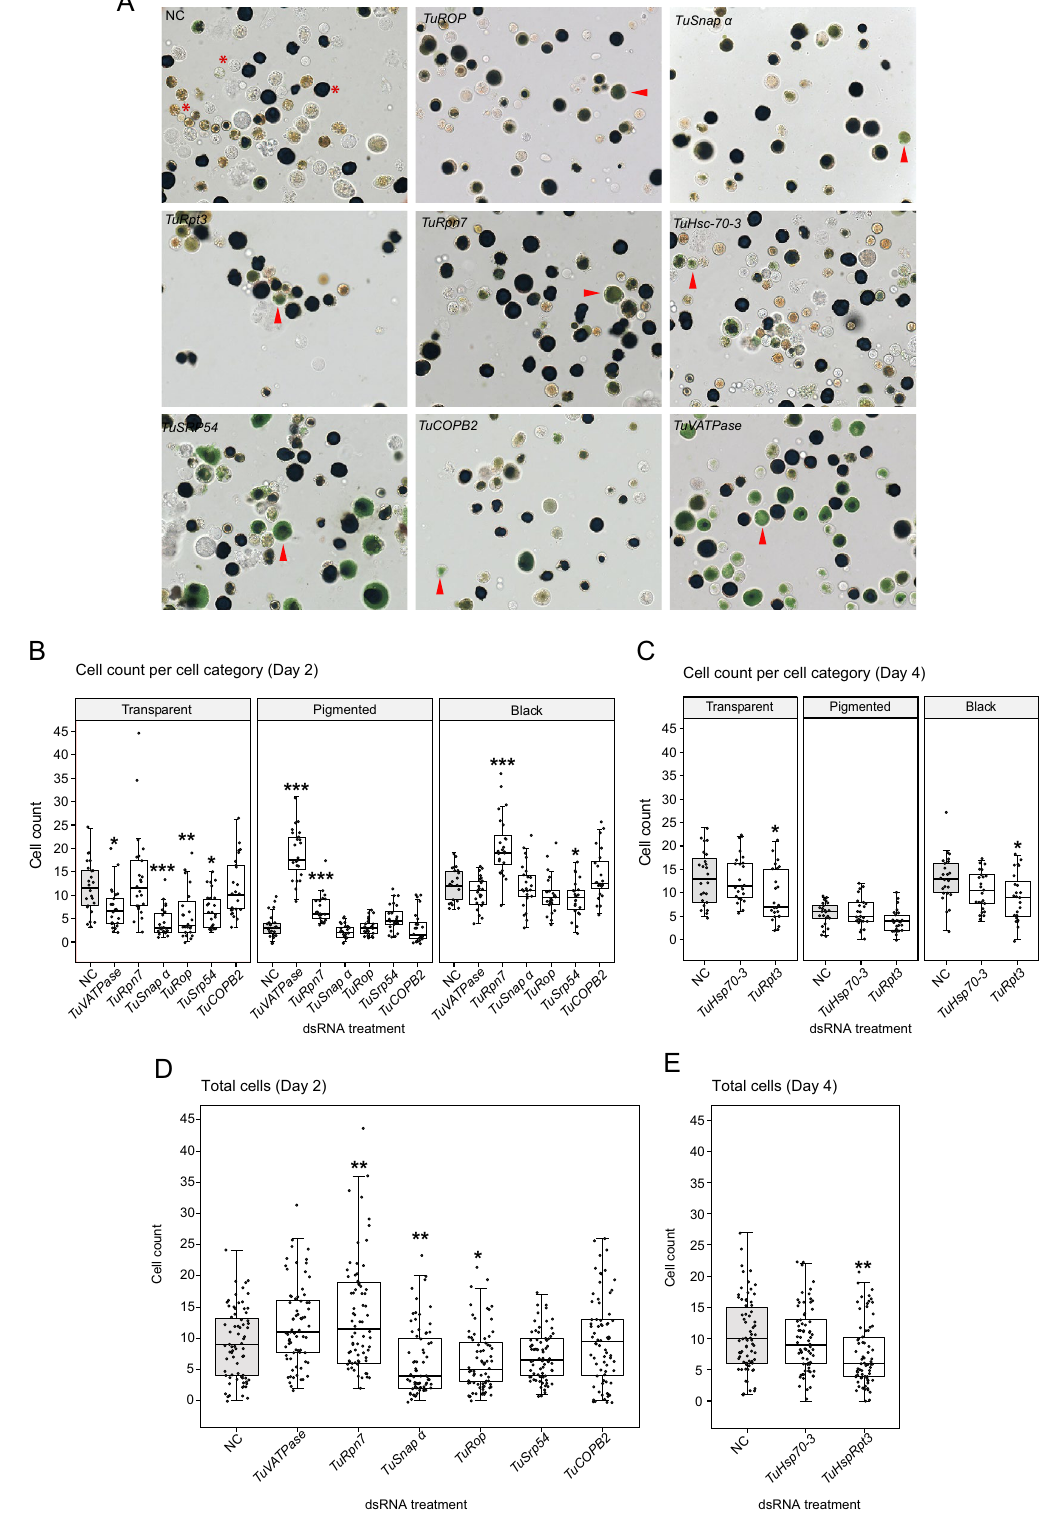
Figure 7. The effect of dsRNA treatments on digestive cells. ( A ) Representative images of digestive cells dissected from RNAi-treated mites. Digestive cells undergo maturation from transparent, pigmented to black, see cells labeled with asterisk in NC panel. ( B , C ) Cell count per cell type category: transparent, pigmented, and black at 2 days ( B ) and 4 days ( C ) post RNAi treatment. ( D , E ) Total cell counts at 2 days ( D ) and 4 days ( E ) post RNAi treatment. The box indicates the first and the third quartile, the middle line represents the median, and the whiskers indicate the 1.5 interquartile range. Individual data points are plotted as grey circles. Statistical analysis was performed using a negative binomial regression followed by posthoc pairwise comparisons between estimated marginal means of each RNAi treatment against the control group with subsequent P -value adjustment following the Bonferroni method (not significant, P > 0.05; * P < 0.05; ** P < 0.01; *** P <